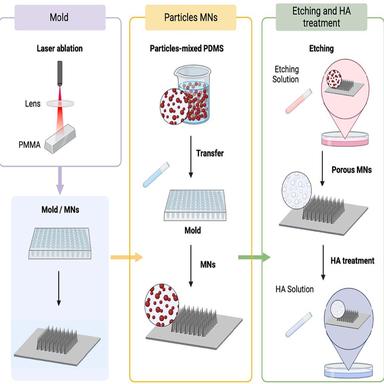
Schematic representation of the main steps for the PDMS PMN fabrication.